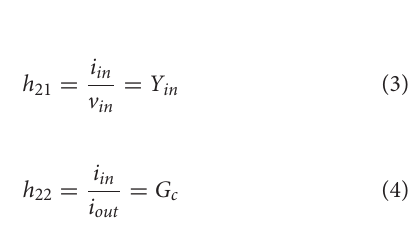
FIGURE 2 | Preliminary design of space high-voltage power module topology and its operating modes. (A) Space high-voltage power module topology. (B) The first half-period. (C) The second